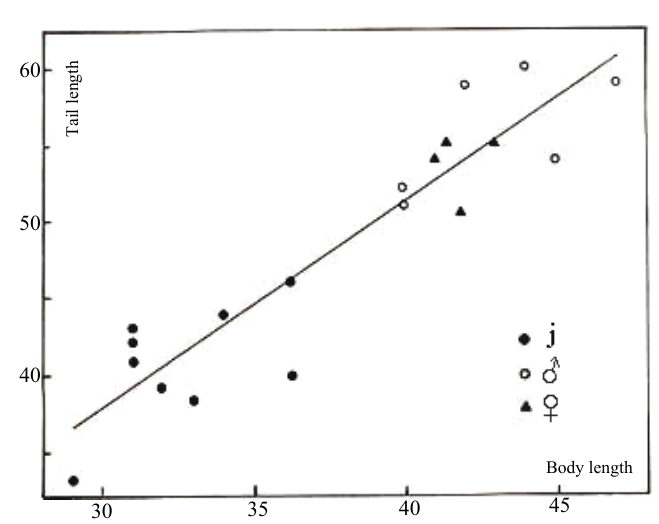
Graph 2 – Gymnodactylus carvalhoi . Regression of tail length on body length, Serra da Mesa, Go.